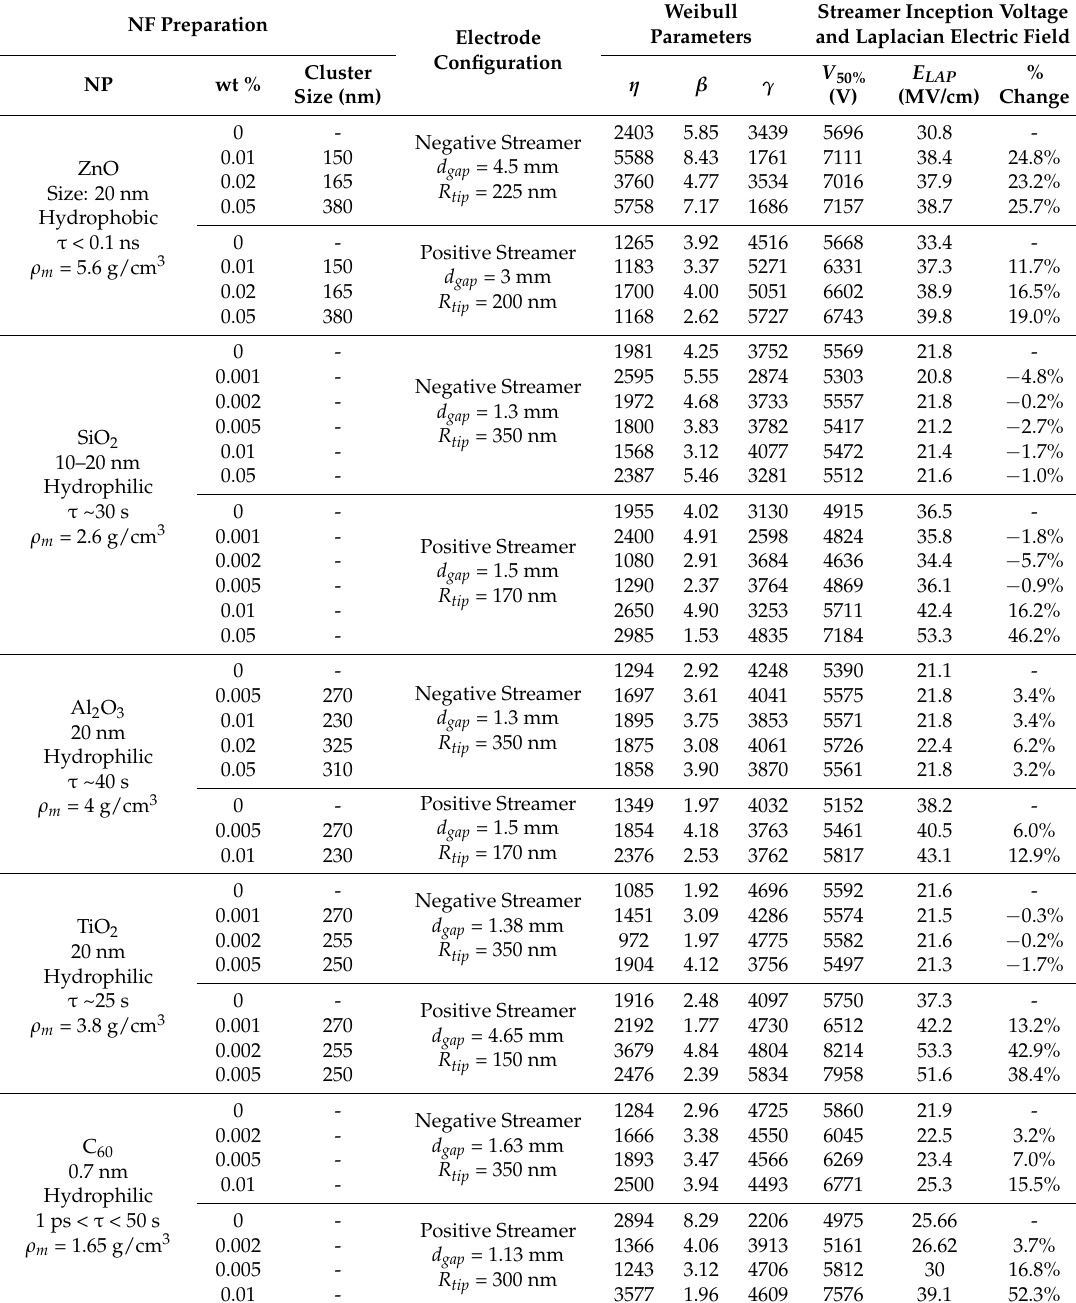
Table 1. Nanofluids preparation details and results of the streamer inception